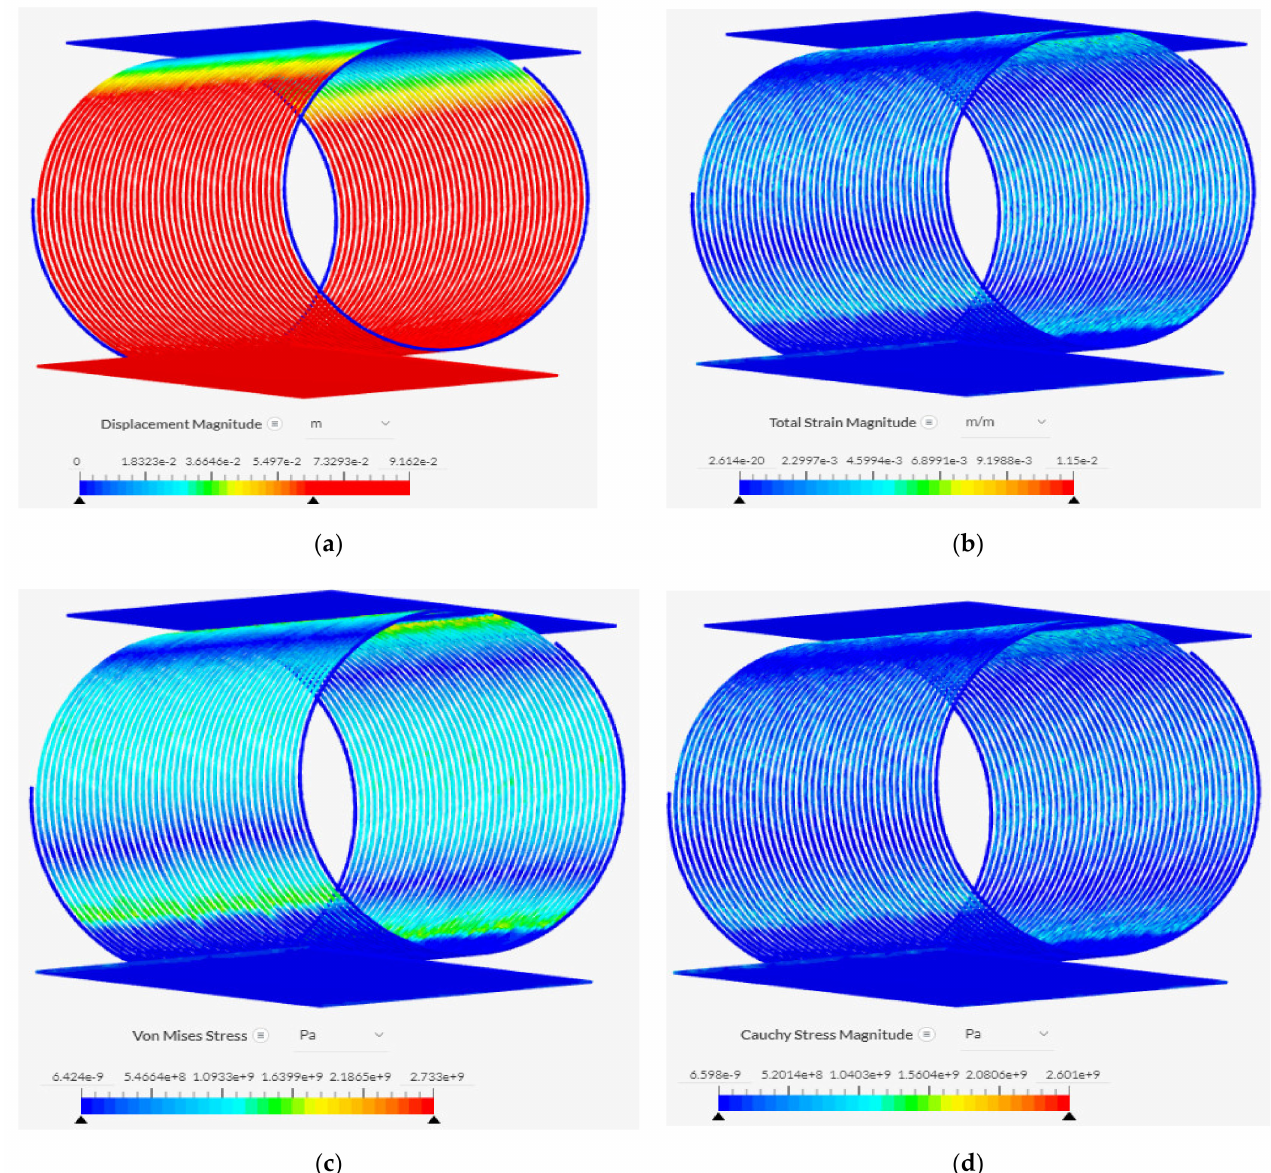
Figure 12. Compression on reinforcement helix for the bonded flexible hose, showing ( a ) deformation, ( b ) total strain magnitude, ( c ) von Mises stress, and ( d ) Cauchy stress using